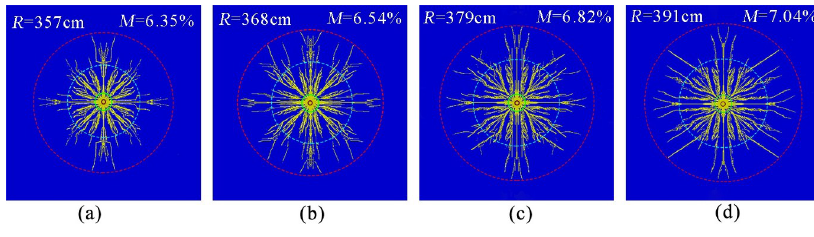
Fig 6. Crack distribution under different gas pressures. (a)Gas pressure 2 MPa.(b)Gas pressure 4 MPa.(c)Gas pressure 6 MPa.(d)Gas pressure 8